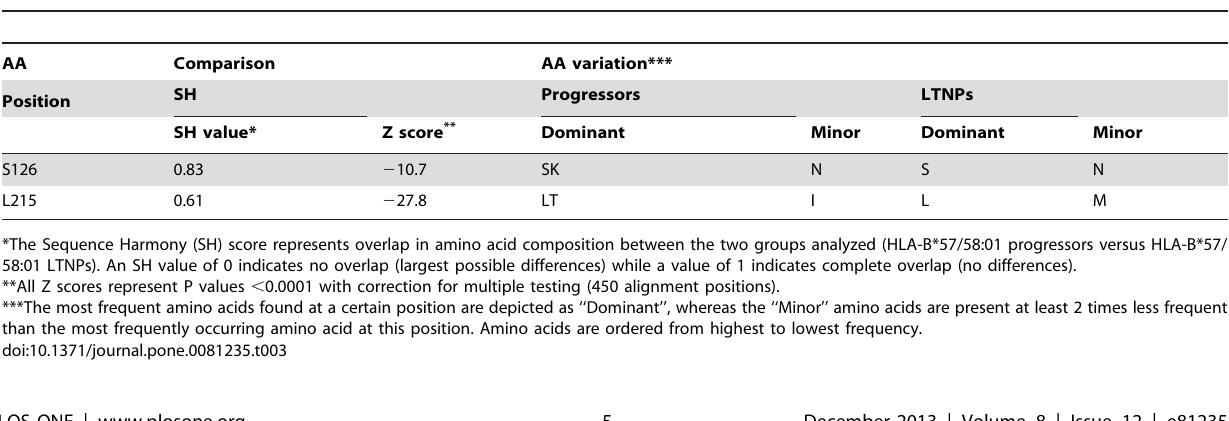
Table 3. Amino acid variation in Gag p17 and p24 associated with HLA-B*57/58:01 disease progression.